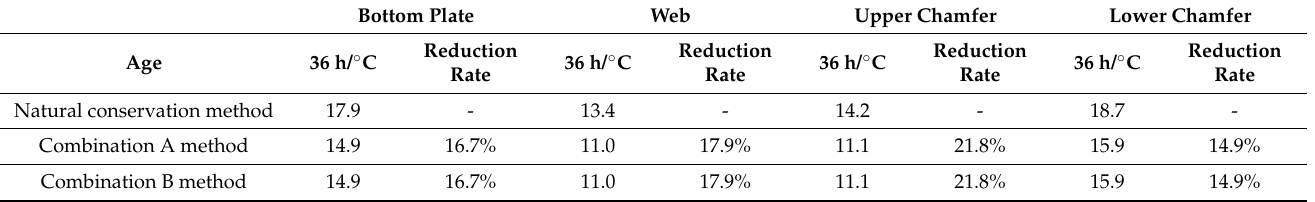
Table 3. Peak temperature variation of box girder using different curing methods before demolding.